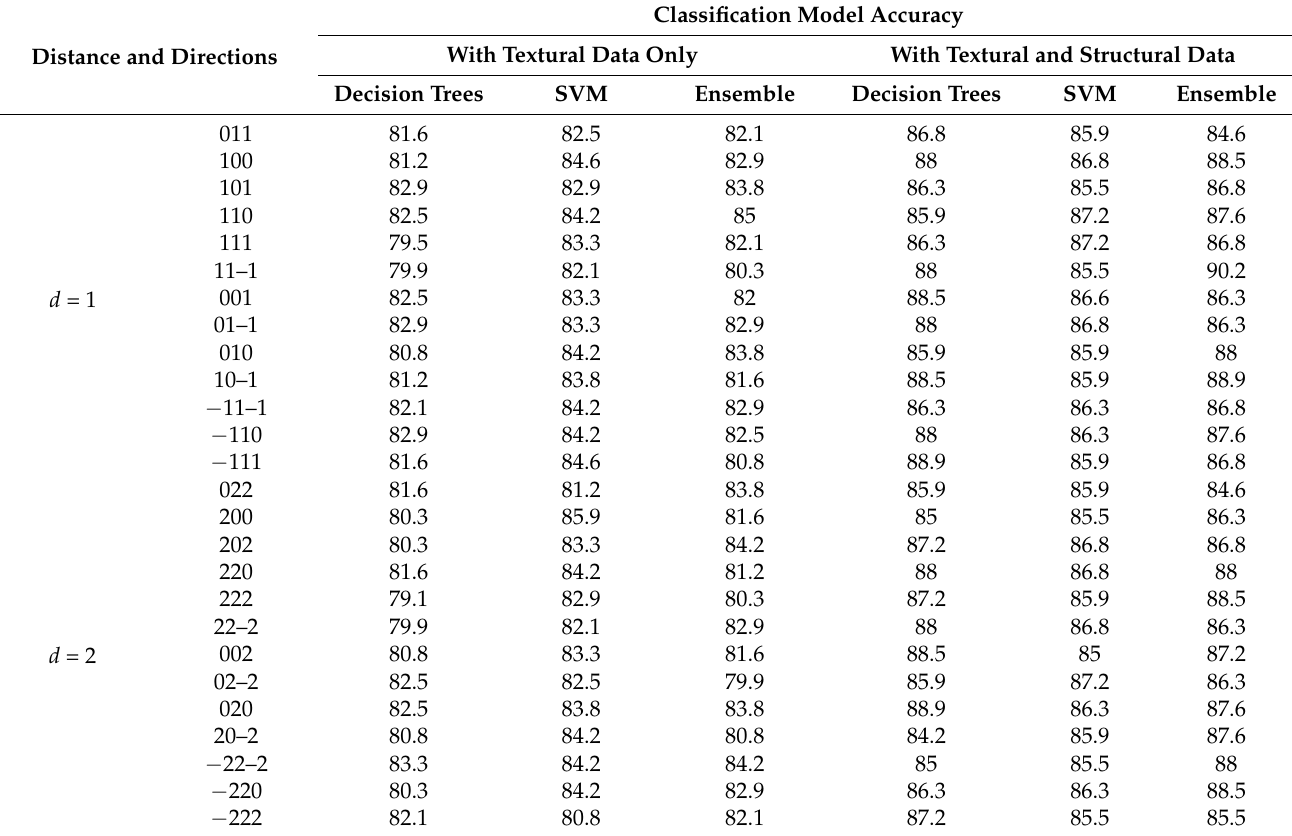
Table 5. Classification accuracy with Textural and Structural data as input.